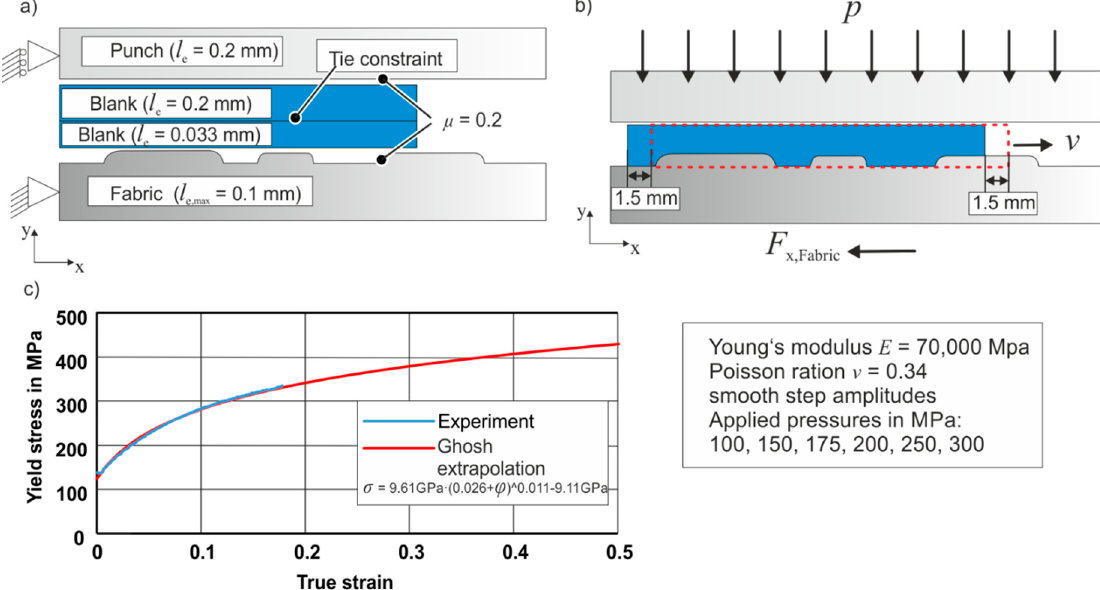
Figure 9. Simplified numerical model: ( a ) initial state; ( b ) simulated process with pressure and displacement; and ( c ) material and simulation process parameters.